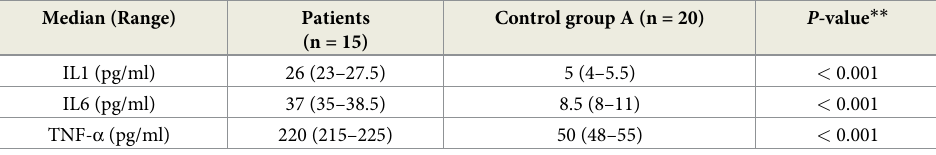
Table 7. Differences in the proinflammatory cytokine levels between patients and control group A.